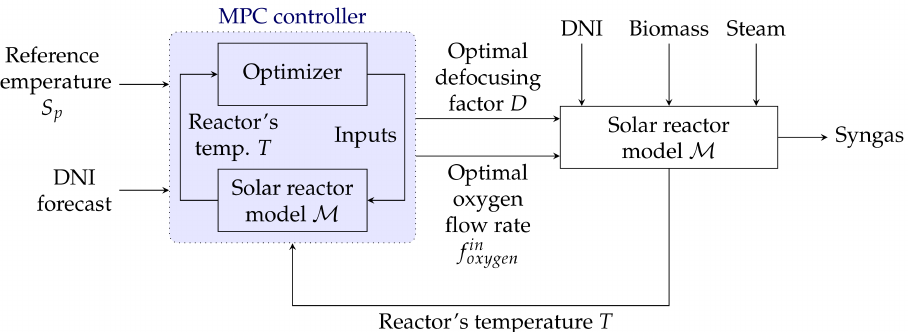
Figure 10. The MPC controller. The optimizer used is the trust-region constrained algorithm